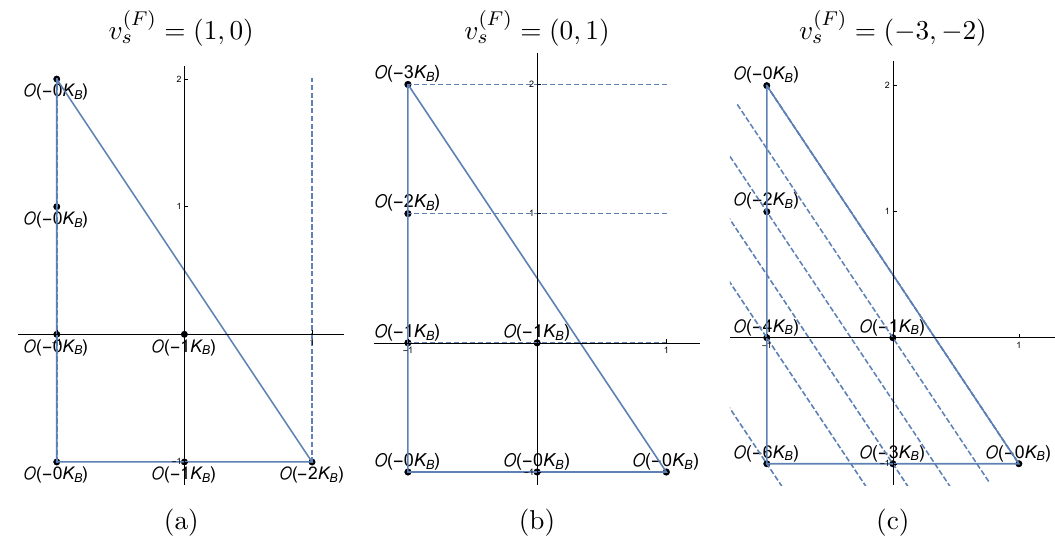
Figure 1 . Di(cid:11)erent choices of the point v ( F ) s used to specify a stacking construction are associated with di(cid:11)erent \twists" of the F -(cid:12)ber bundle over the base B . The di(cid:11)erent choices of v ( F ) s